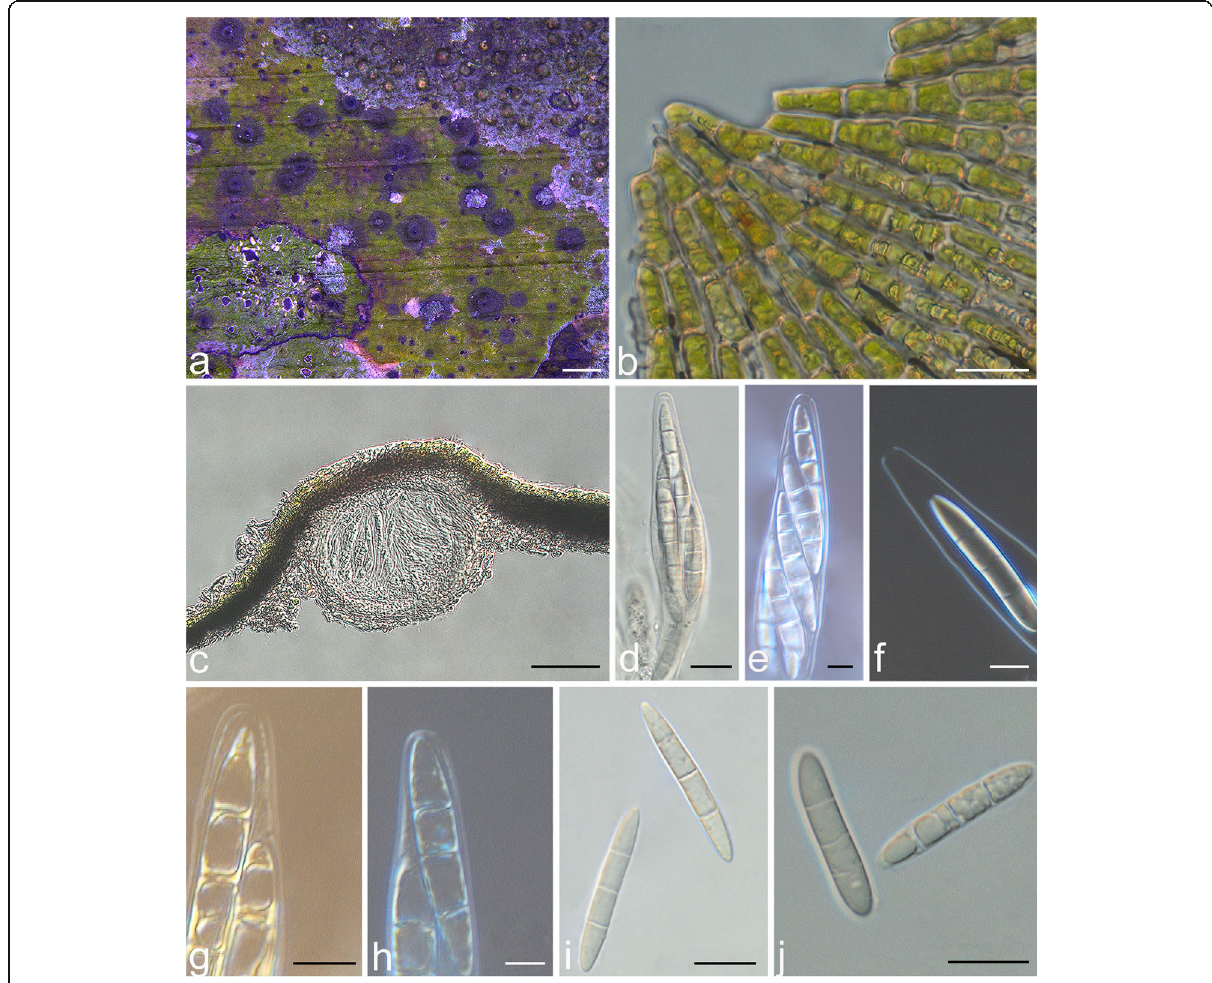
Fig. 1 Tenuitholiascus porinoides (HMAS – L0139638). a Thallus. b The Phycopeltis algal partner. c Perithecia in vertical section. d Ascus (HMAS